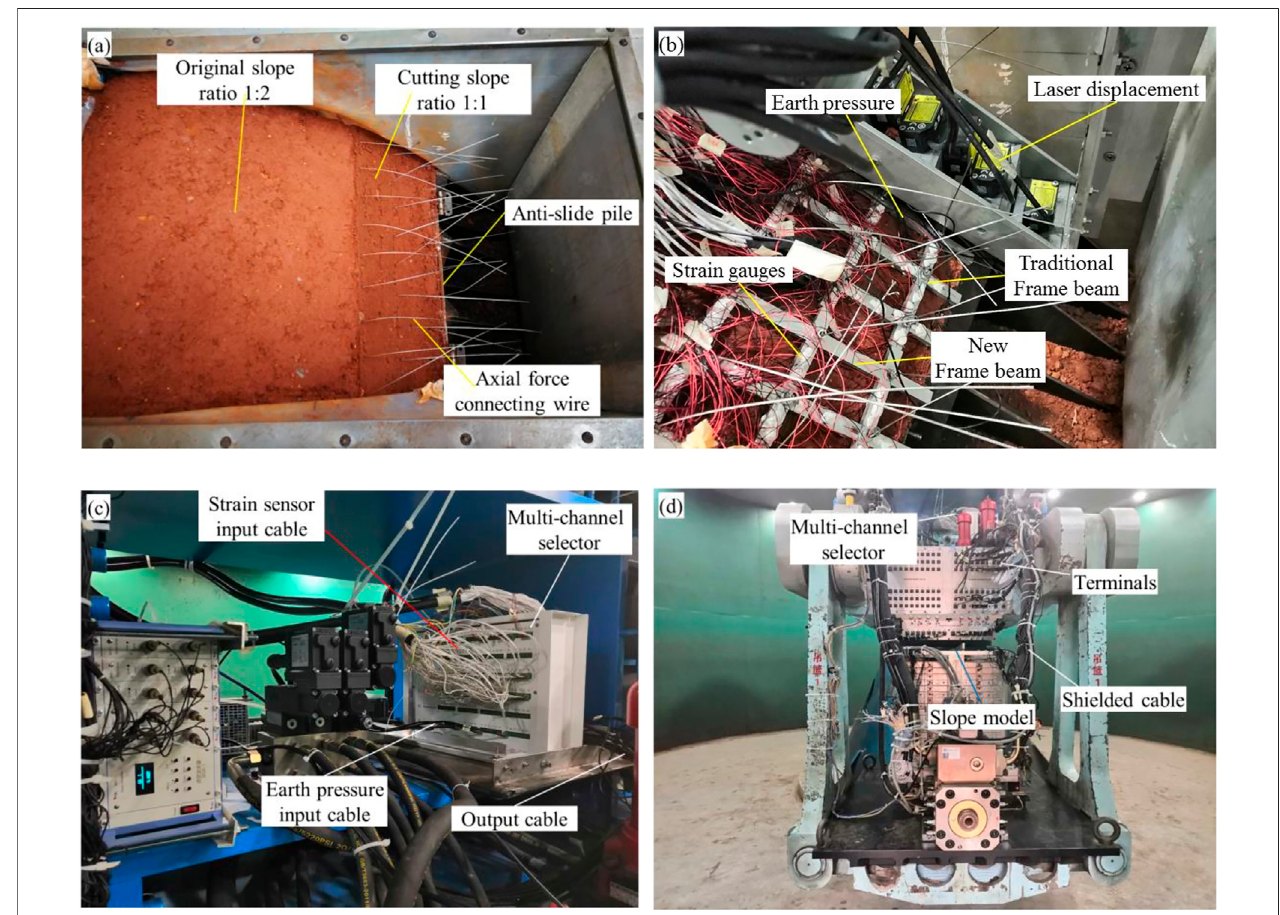
FIGURE10| Processphotosofthecentrifugalmodeltest: (A) slopeformingandaxialinstallation; (B) framebeamandsensorinstallation; (C) connectionofvarious cables and multi-channel acquisition instrument; (D) all cable connection renderings.